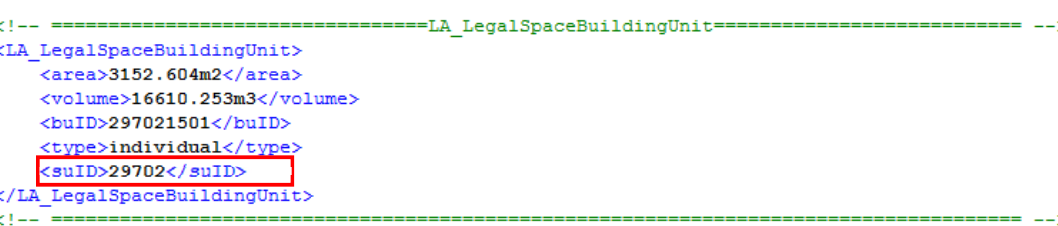
Figure 11. Part of a referenced XML document defined LA_LegalSpaceBuildingUnit in LADM.